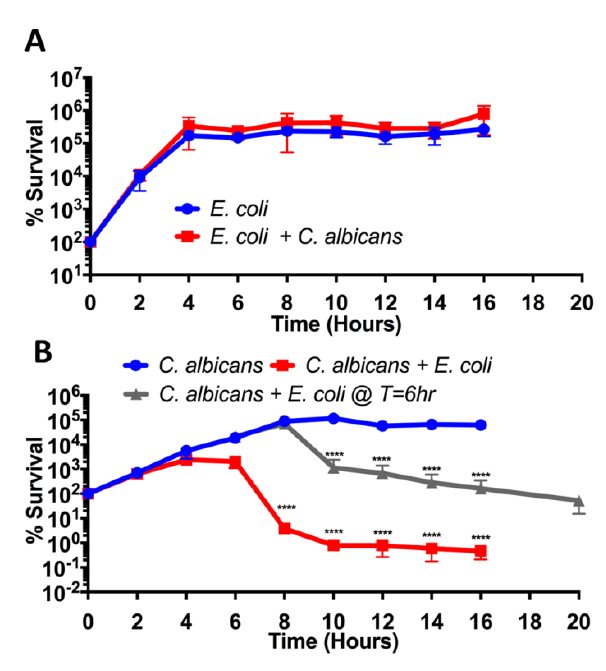
FIGURE 1: E. coli kills C. albicans in culture . (A) Percent survival of E. coli cultured alone or in co-culture with C. albicans. (B) Percent survival of C. albicans cultured alone or in co-culture with E. coli added at T=0 hours or at T= six hours . Data shown reflect mean ± SD of n = 3. Statistical significance was calculated using a two-way ANOVA in Prism 7.0. For each time point, both C. albicans + E. coli media types were compared to the C. albicans media control. P- values were subsequently corrected for multiple comparisons using the Bonferroni method. **** denotes an adjusted p-value of less than 0.0001. No time points were found to be statistically significant in Figure